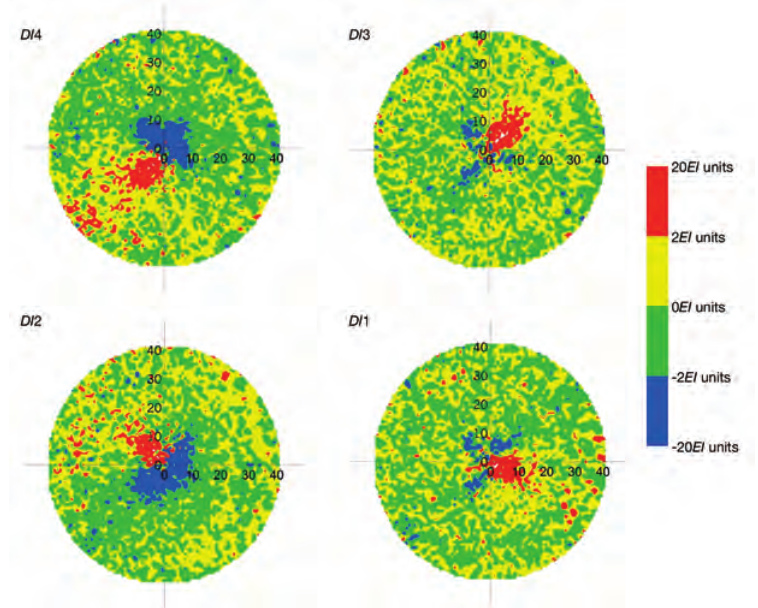
Fig. 8. Differences DIb between the normalised EIb and the average over the 3 other EIb s versus the current direc- tion (north is upward) and cell number. The diagrams can be analysed as if the observatory were in between them.